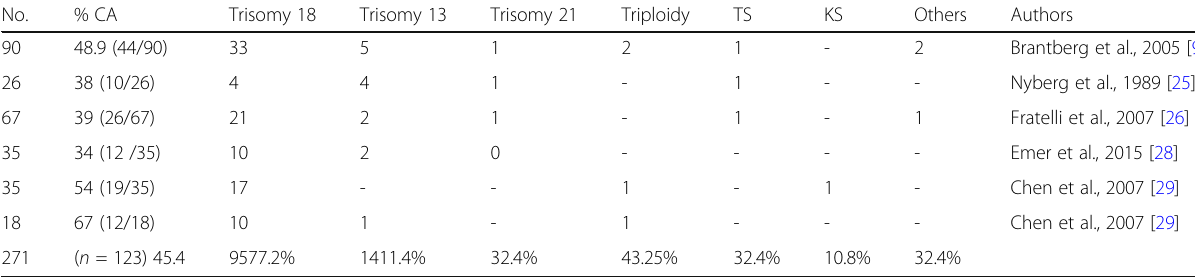
Table 1 Median incidence of common chromosomal anomalies in omphalocele